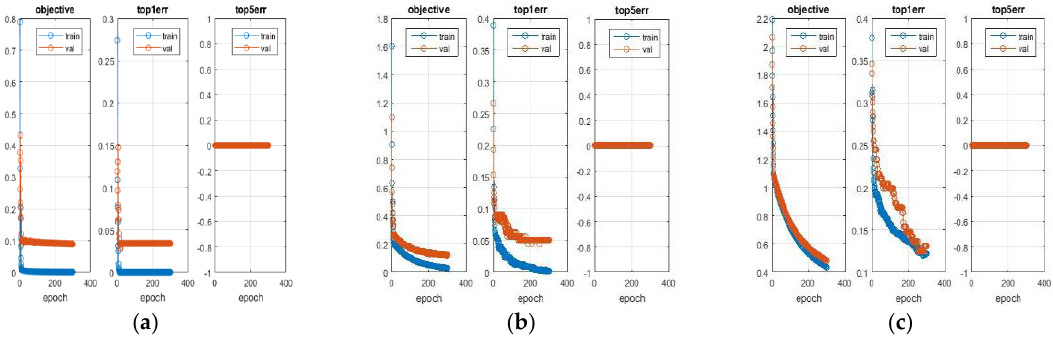
Figure 21. ( a ) Learning rate is 1 × 10 −4 ; ( b ) learning rate is 1 × 10 −5 ; ( c ) learning rate is 1 × 10 −6 .